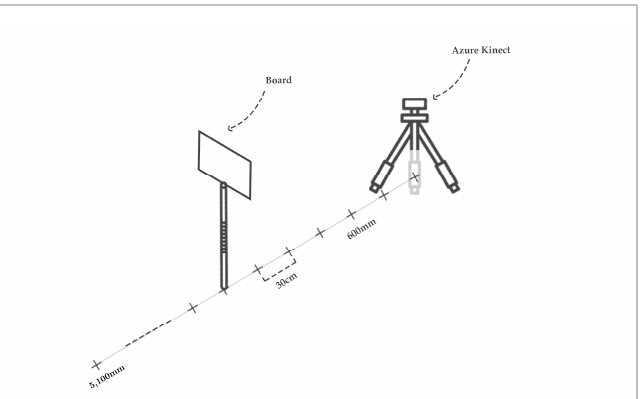
Figure 3. Operating modus for testing the influence of different ranges on measurement accuracy.